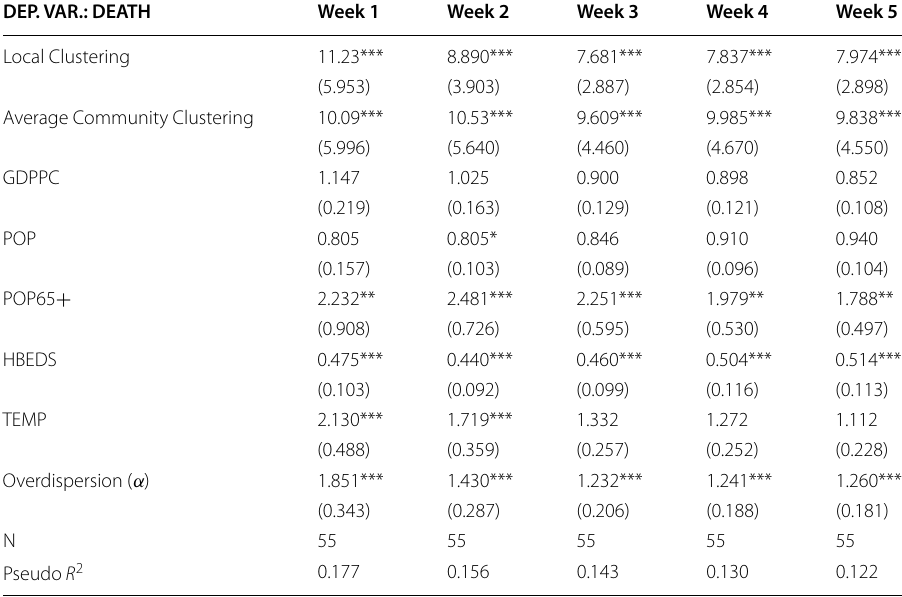
Country‑level clustered standard errors in parentheses. All the estimates also include a constant